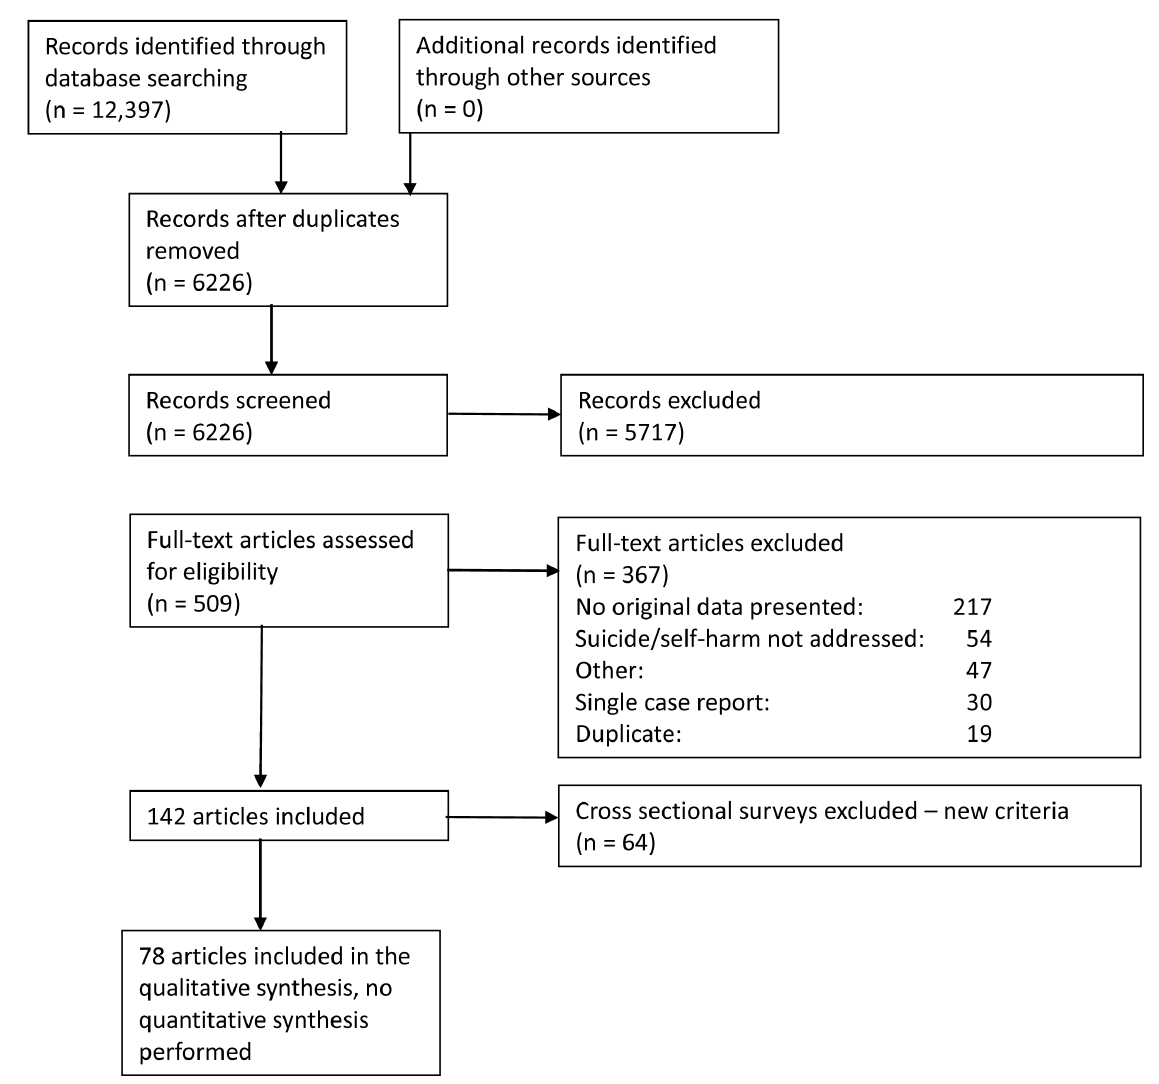
Figure 2. PRISMA flow